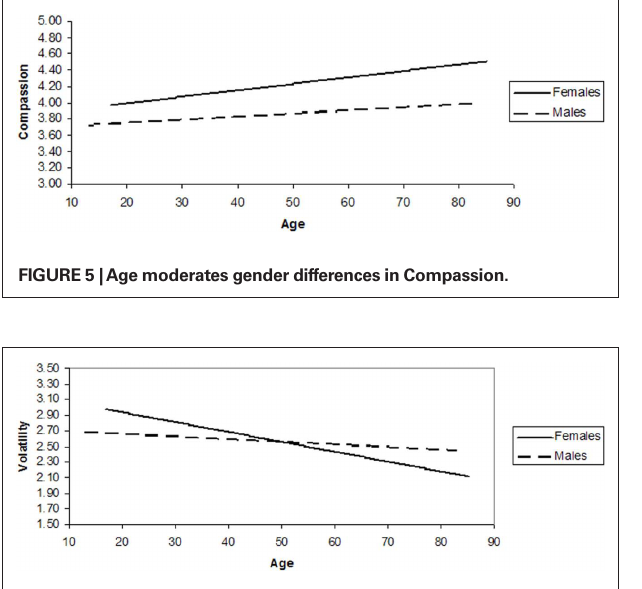
FIguRE 6 | Age moderates gender differences in Volatility.